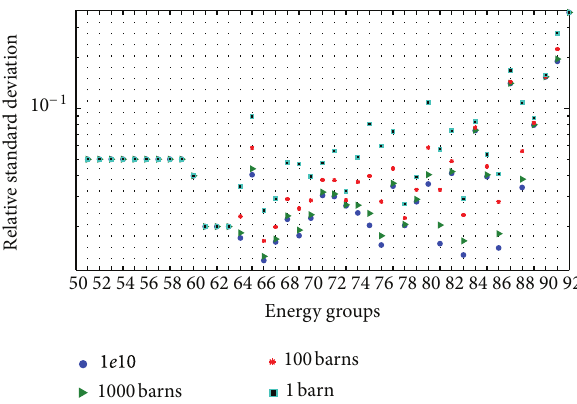
F 8: Relative standard deviation as a function of background cross-section at the resonance groups for the